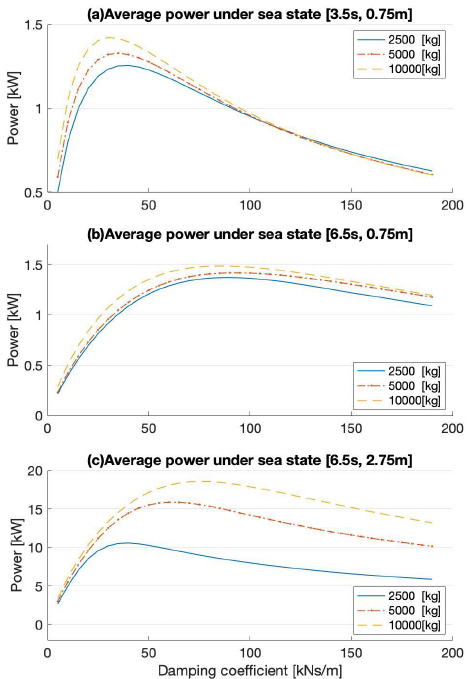
Figure 6. The average captured power in response to the damping coefficient with three different translator masses, 2500 kg/5000 kg/10,000 kg. The profiles were obtained under three sea states: ( a ) (3.5 s, 0.75 m); ( b ) (6.5 s, 0.75 m); ( c ) (6.5 s, 2.75 m).